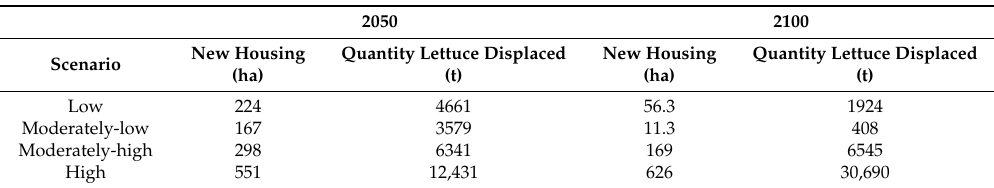
Figure 4. GHG emissions (kg CO 2 -e yr-1) per area of PU land transformed normalised for population change, under the four future scenarios at time horizons 2050 and 2100. Table 4. PU land consumption by new housing in greenfield areas and associated food displacement under the four future scenarios.